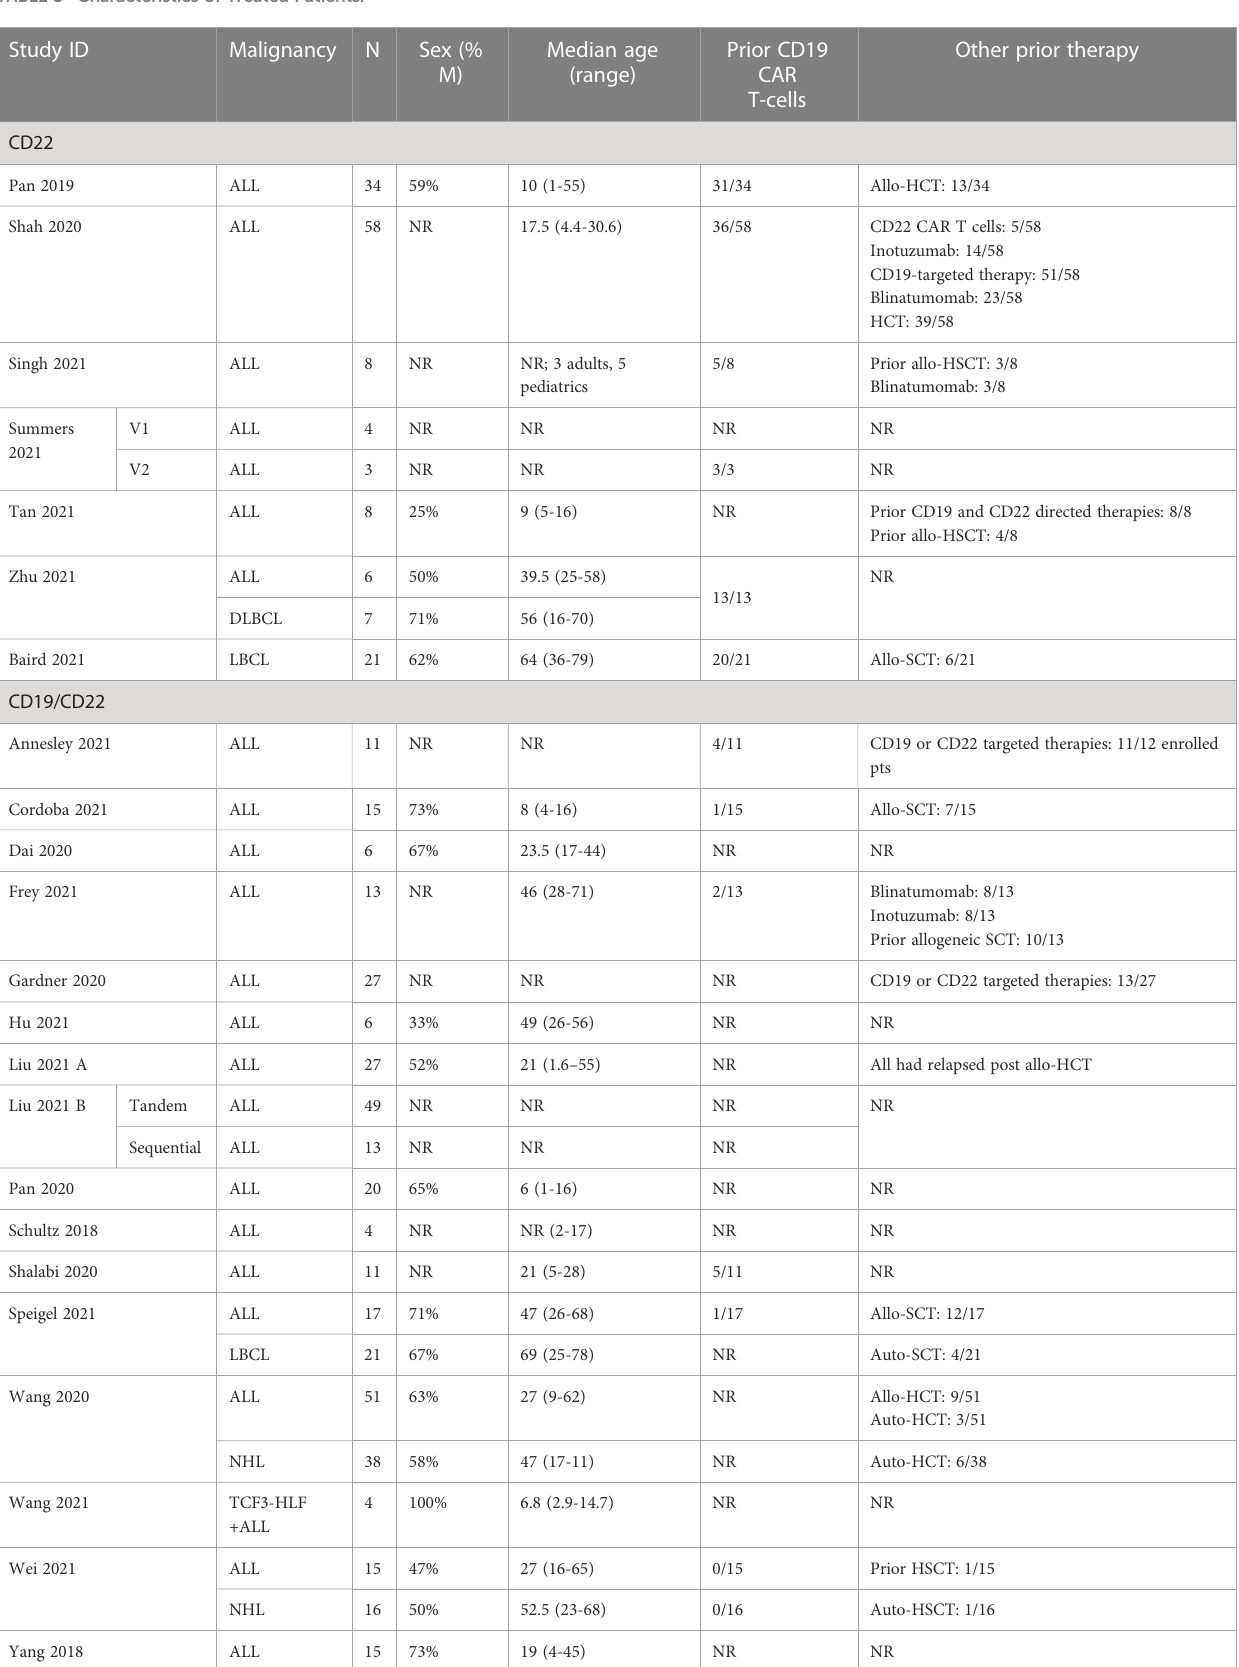
TABLE 3 Characteristics of Treated